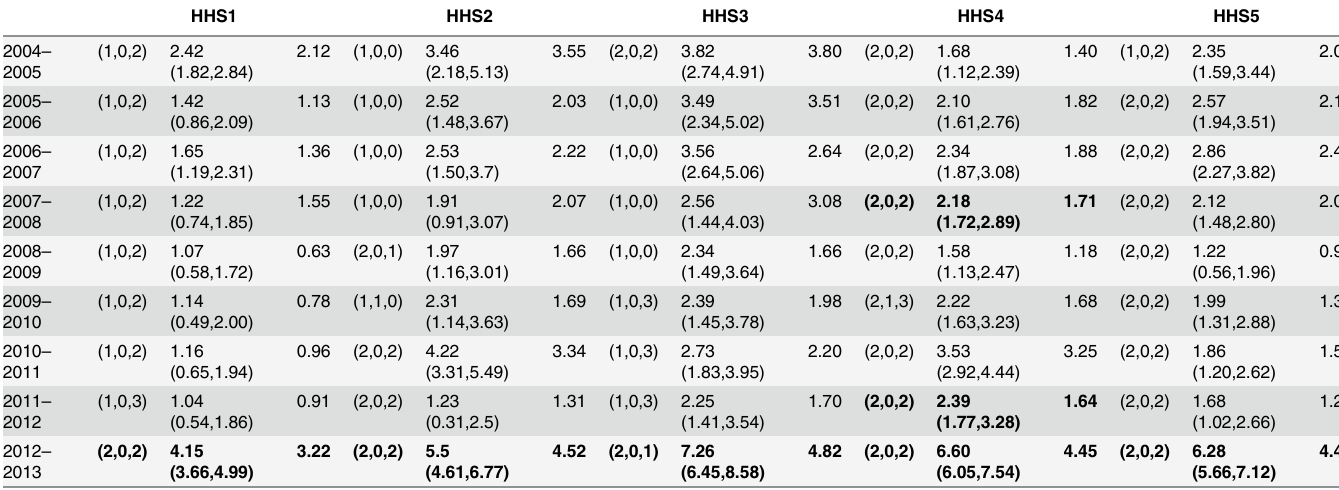
Table 3. Week 1 ILI rate prediction for HHS regions 1 – 5 from influenza seasons 2004 – 2005 to 2012 – 2013.